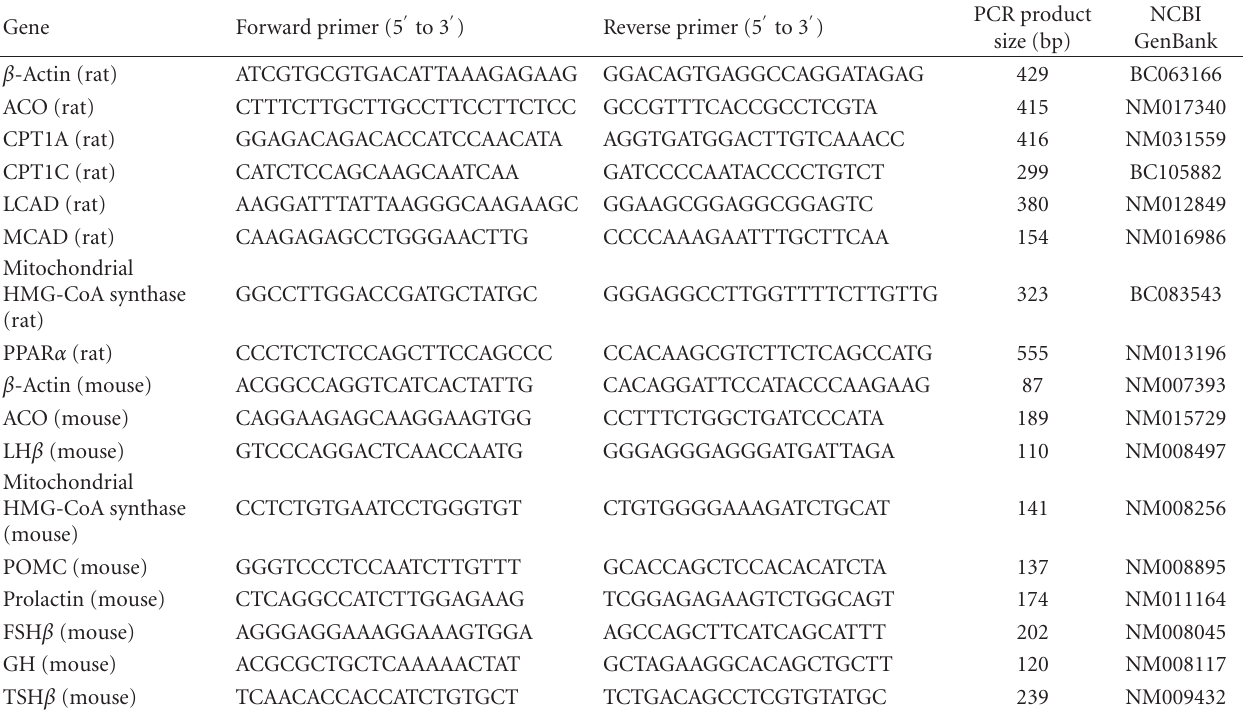
Table 1: Characteristics of the specific primers used for RT-PCR analysis. Gene Forward primer (5 (cid:3) to 3 (cid:3)